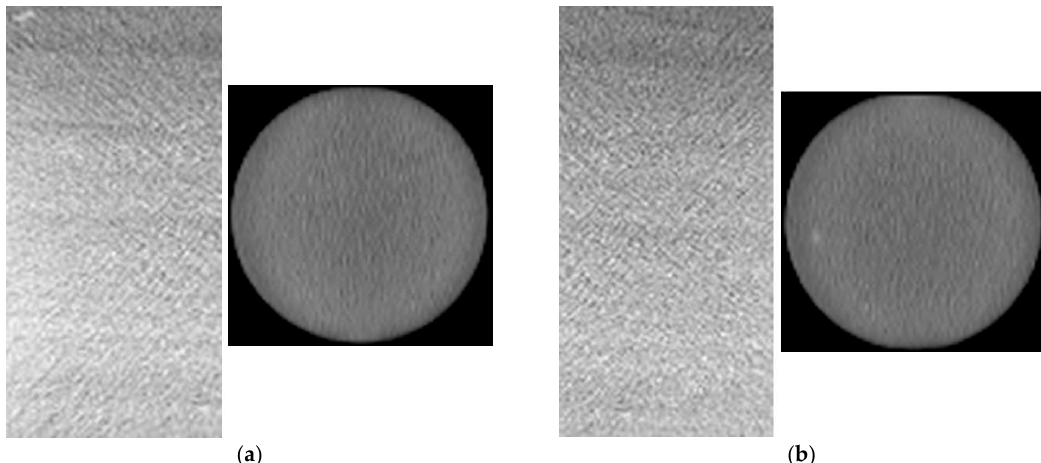
Figure 4. CT images of the shale sample before and after the drying process. ( a ) Before drying; ( b ) after drying.